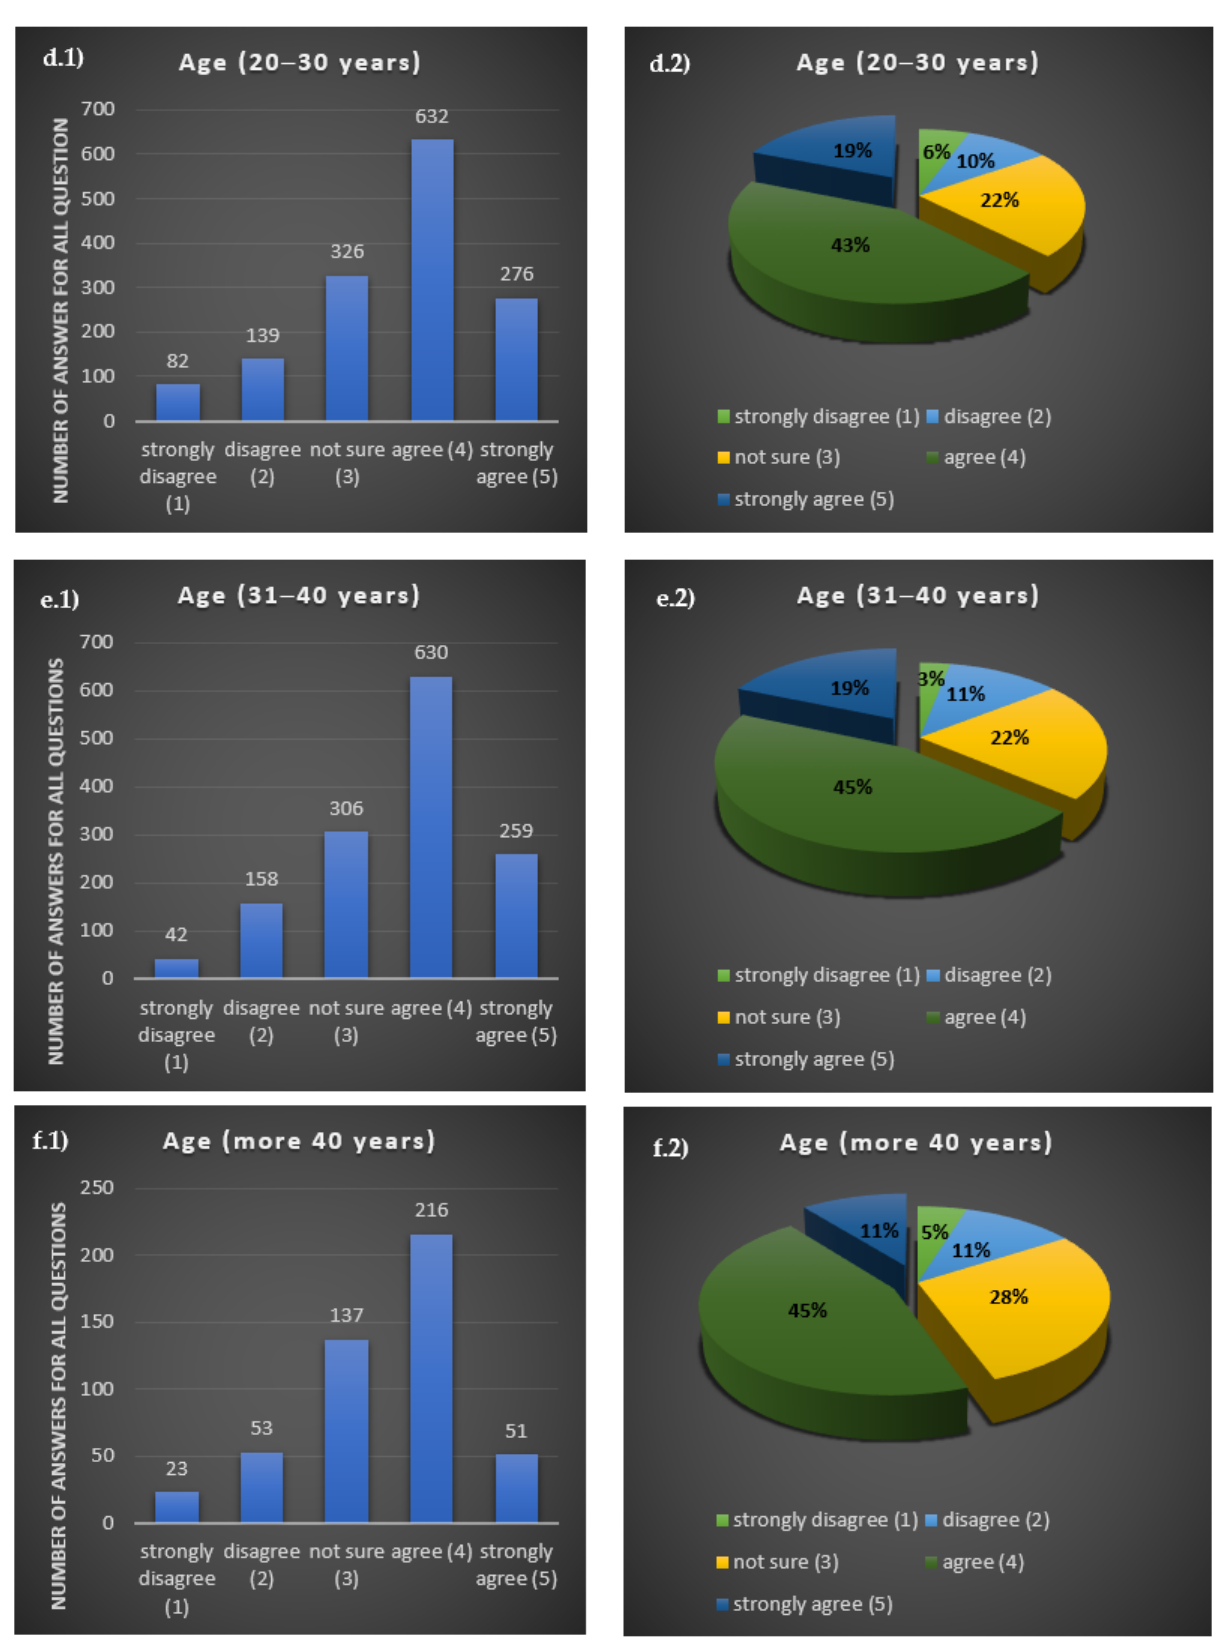
Figure 9. Survey questions visualization for females ( a ) and males ( b ) and all ages groups ( c1 – f2 ).